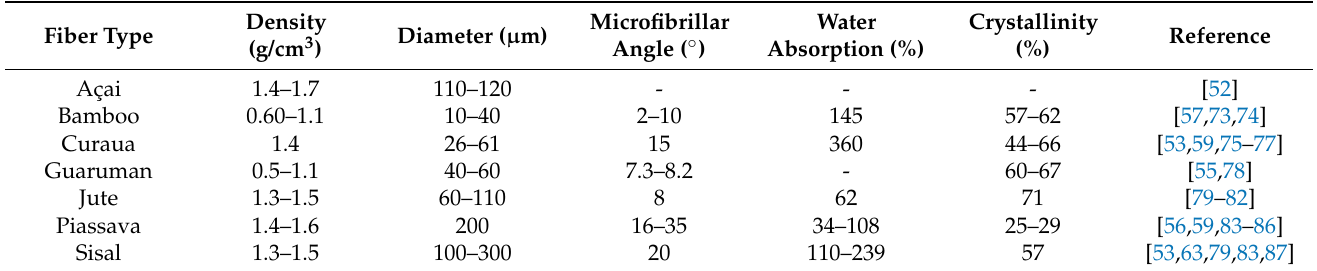
Table 2. Physical properties of Amazon